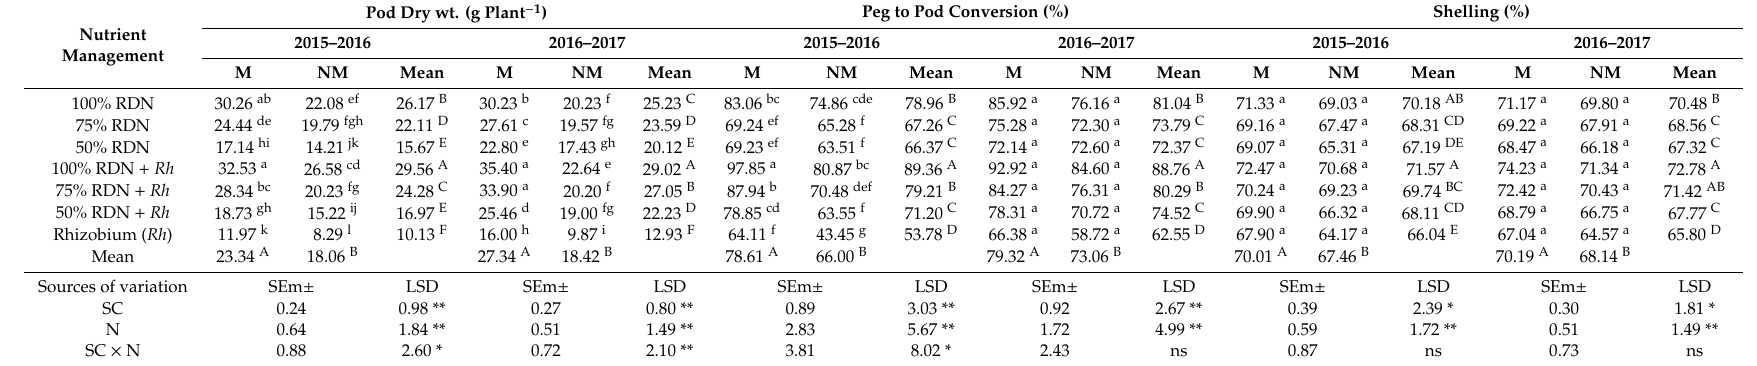
Table 3. E ff ect of soil covering and nutrient management on yield and yield attributes of peanut in 2015–2016 and